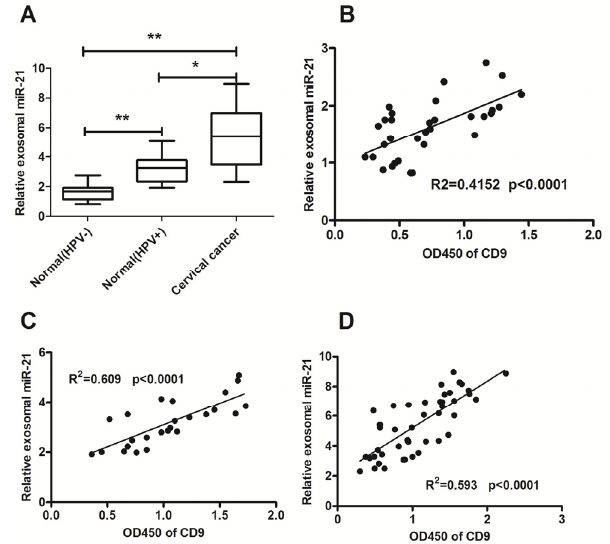
Figure 2. Enriched exosomal microRNA-21 in cervicovaginal lavage specimens of cervical cancer patients. ( A ) The relative amounts of exosomal miR-21 were examined by RT-qPCR in cervicovaginal lavage specimens of the normal subjects with HPV-negative ( n = 32), subjects with HPV-positive ( n = 25), or cervical cancer patients ( n = 45). The lowest expression in the normal HPV-negative group was designated as “1”. All other samples were expressed as a relative value according to the ratio of their Cp value to the Cp value of the designated sample; ( B – D ) The correlation between the miR-21 expression and the levels of exosomes was evaluated by RT-qPCR and ELISA; ( B ) HPV-negative normal group; ( C ) HPV-positive group; ( D ) Cervical cancer group. All experiments were performed in triplicate. Statistical significance was considered with a p < 0.05 ( * ) or p < 0.01 ( **